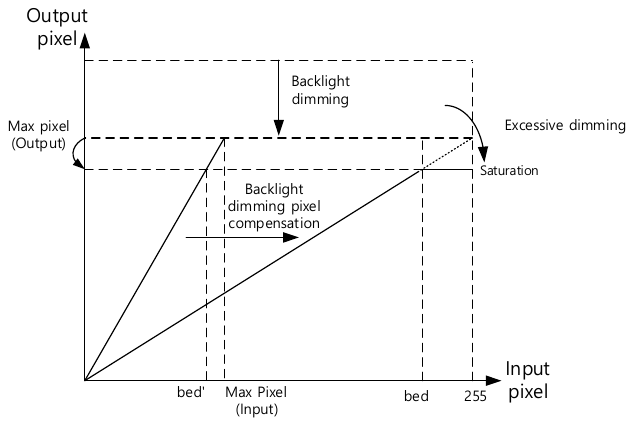
Figure 1. Pixel compensation for excessive dimming.